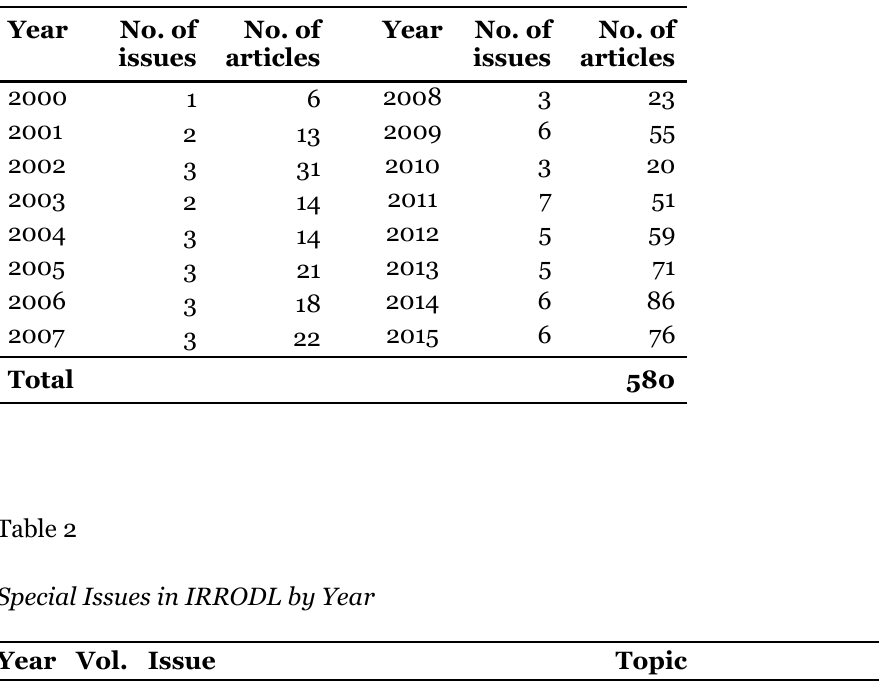
Frontiers in open and distance learning in the North Connectivism: Design and delivery of social networked learning Prior, Experiential and Informal Learning in the Age of Information